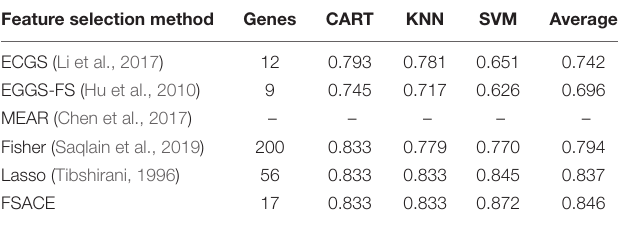
TABLE 9 | Classification accuracy of Ting using six different feature selection